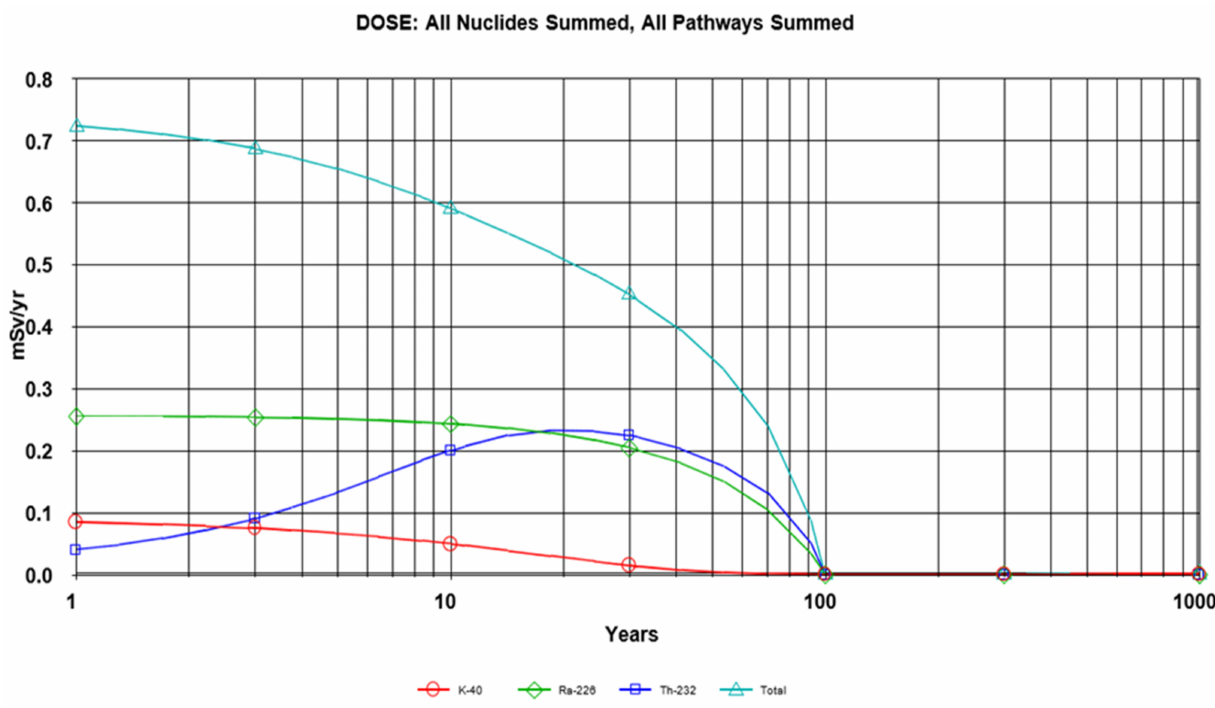
Figure 3. Summed total dose due to all nuclides and all